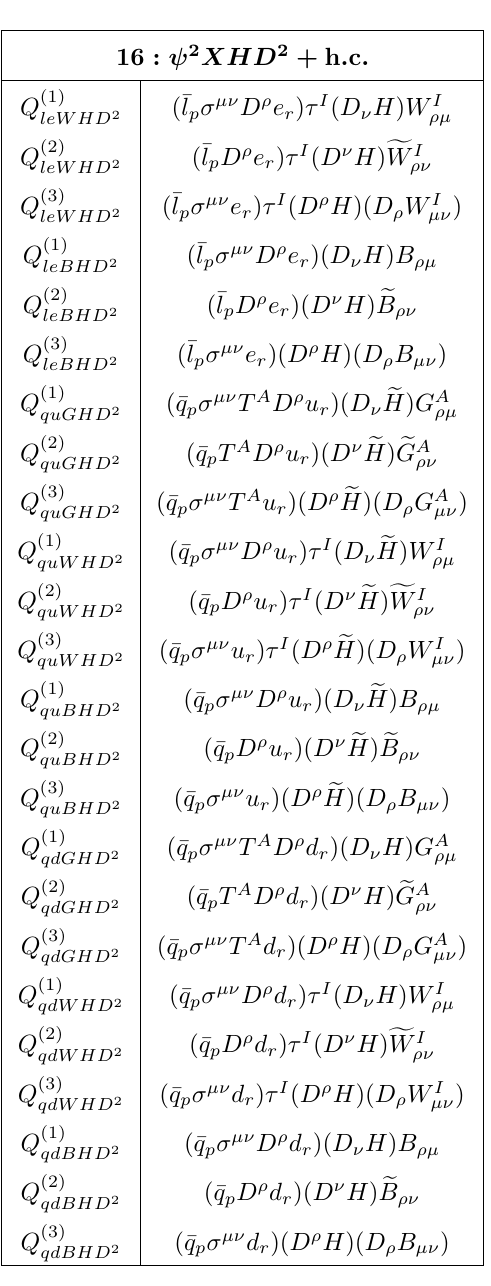
Table 9 . The dimension-eight operators in the SMEFT of classes-16, and -17, which have two fermions and two derivates. All of the operators have Hermitian conjugates. The subscripts p; r are weak-eigenstate indices.